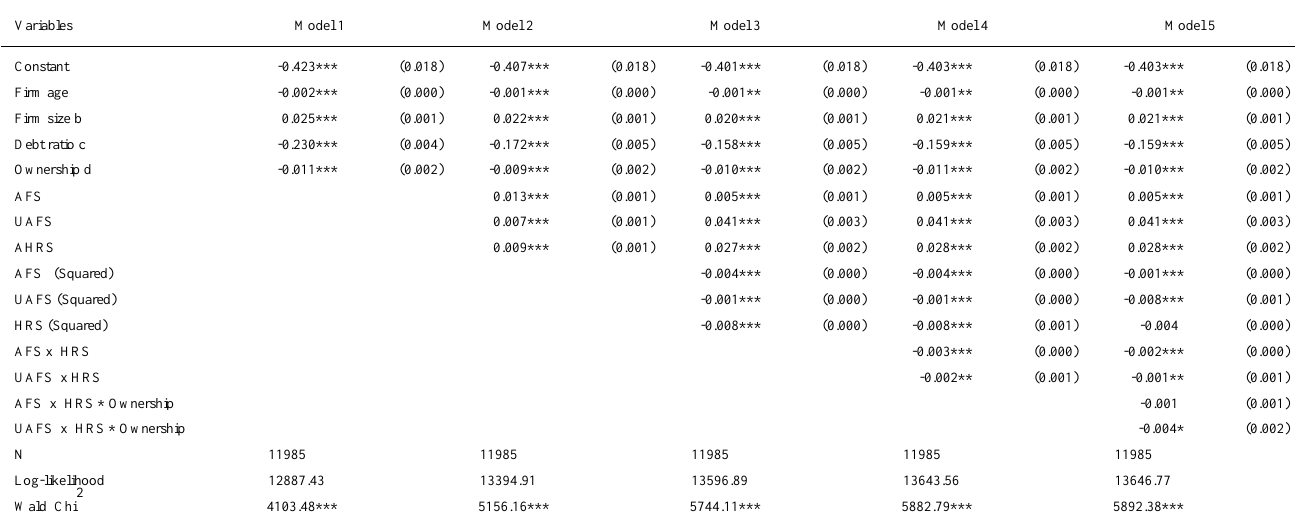
Table 2: Regression analysis result of human resource, financial slacks, and their interaction and firm performance